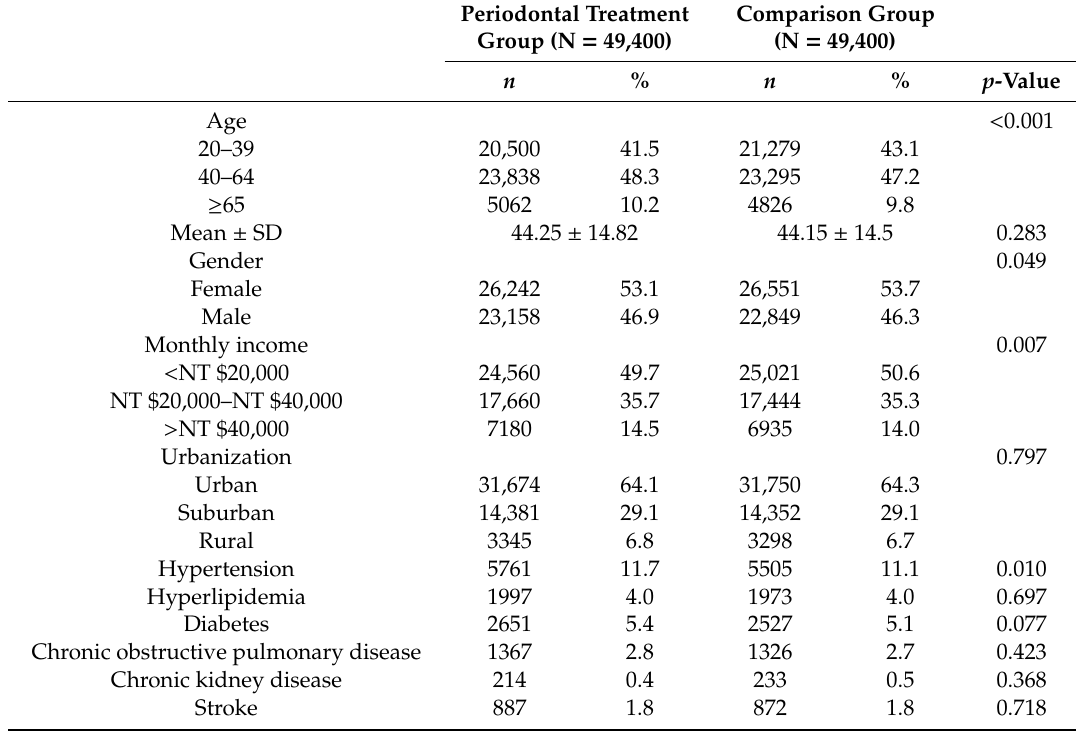
Table 1. Demographic data of matched study